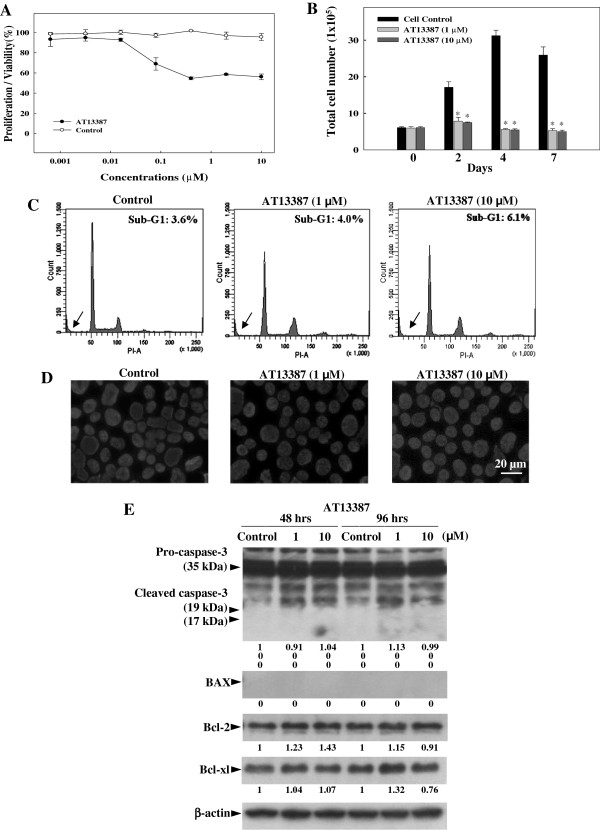
Effect of AT13387 on EBV-positive NPC cell line C666-1. (A) MTT assay showing dose dependent inhibition of C666-1 cells growth after 48 hrs of AT13387 treatment. (B) Cell growth assay showing the kinetics of growth inhibition determined by counting number of viable C666-1 cells on days 2, 4 and 7 after AT13387 treatment. Results are expressed as the mean ± S.D. of three separate trials; *p < 0.05. (C) DNA content analysis and (D) DAPI nuclei staining showed no significant apoptotic phenotype in AT13387-treated C666-1 after 48 hrs. Arrow indicated the sub-G1 peak of DNA profile. Scale bar = 20 μm. (E) Western-blotting analysis showing no significant change of pro-apoptotic and anti-apoptotic proteins in AT13387-treated C666-1 after 48 hrs and 96 hrs. Value represented the arbitrary unit of band intensity after normalization with β-actin.